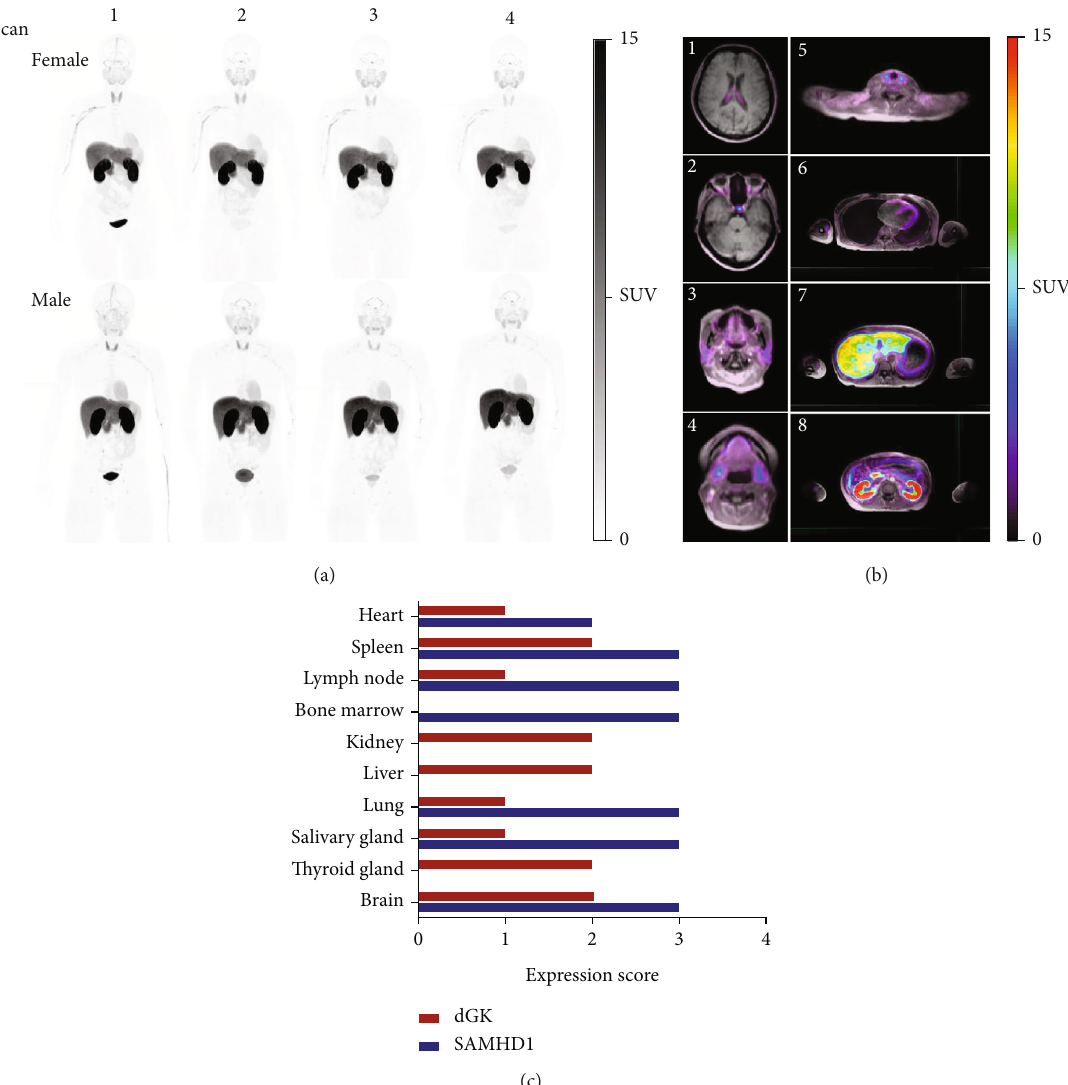
Figure 2: [ 18 F]F-AraG PET images. (a) Whole body maximum intensity projection images at di ff erent time points in a representative female and male subject. (b) Axial slices of fused PET/MRI showing notable uptake in (1) choroid plexus, (2) pituitary gland, (3) parotid gland, (4) submandibular gland, (5) thyroid gland, (6) heart, (7) liver, and (8) kidneys. (c) Tissue expression of dGK and SAMHD1, extracted from the Human Protein Atlas; 0, 1, 2, and 3 signify no, low, medium, and high expression,